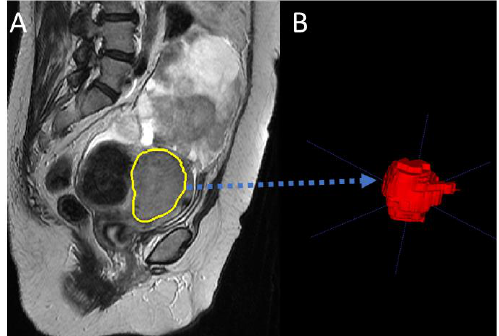
Figure 2. An example of manual tumor segmentation. ( A ) T2-weighted image, the yellow curve shows the location of the tumor; ( B ) segmented tumor mask region in 3D.